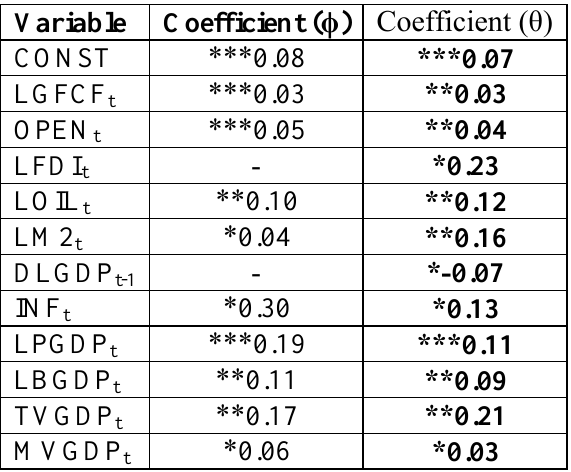
Table 8. Result of the model